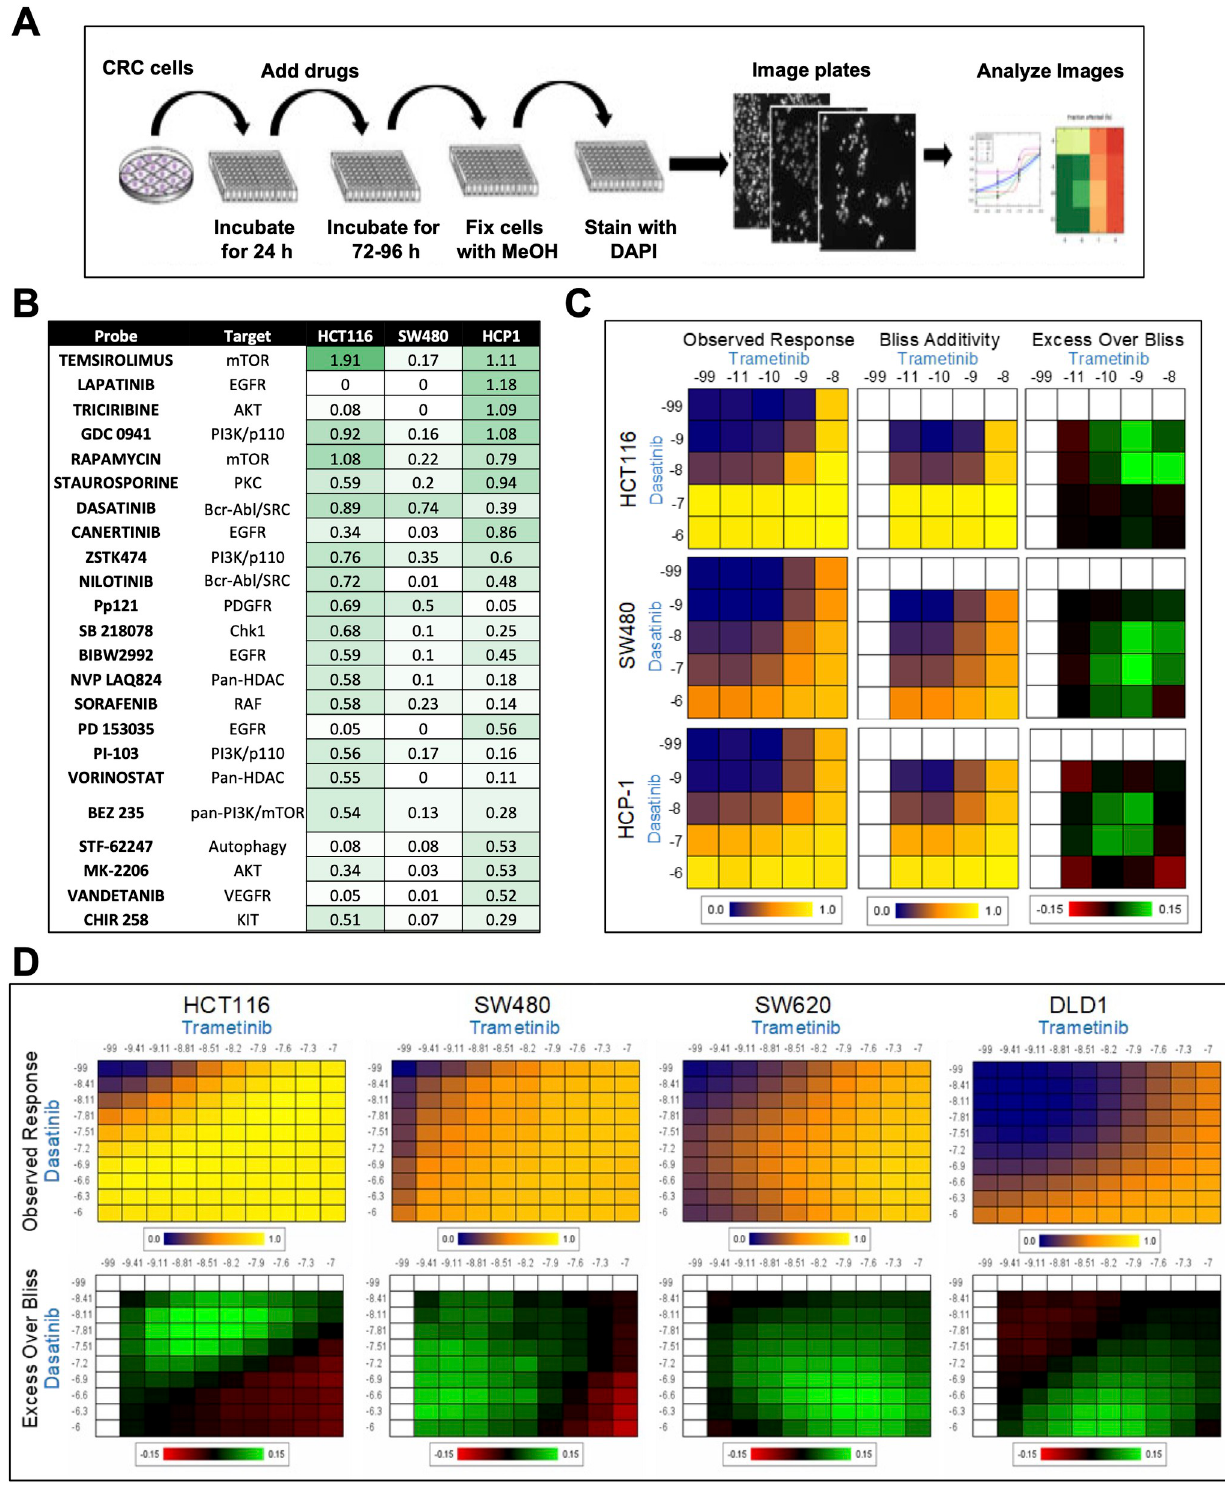
Fig 1. Use of HTS to identify drugs that are synergistic with trametinib. A, schematic of 2D HTS performed to identify drugs that are synergistic with trametinib. B, table of synergy score values for drugs combined with trametinib. A subjective cutoff value greater than 0.5 was considered to indicate synergy. The drugs tested (probes), their targets, and the synergy scores for the cell lines HCT116, SW480, and HCP-1 are shown. C, representative pairwise synergy plots for CRC cells. The left panels show the experimentally observed growth inhibitory/cytotoxic activity (observed response) of single